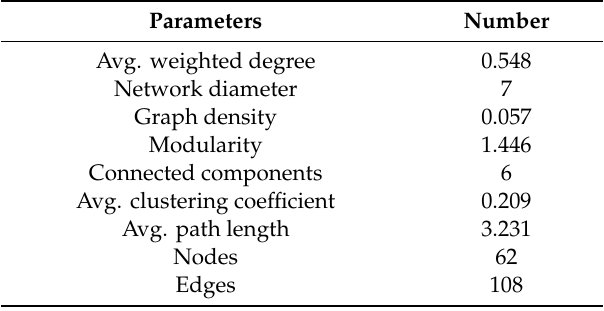
Figure 5. Microscopic images of typical algae in 16 di ff erent urban lakes. Table 3. The networks properties of algal communities at genus